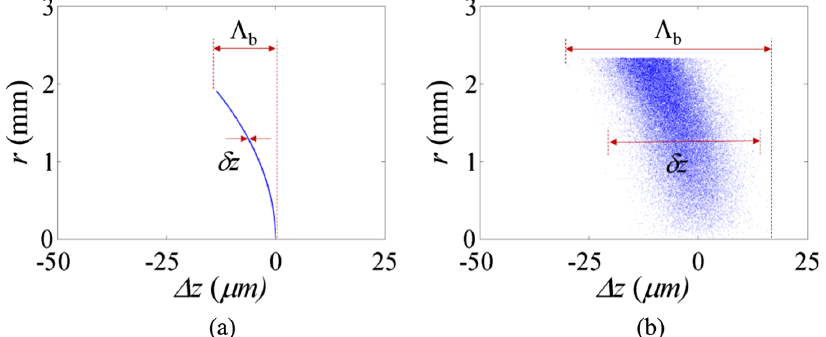
FIG. 2. Half r - Δ z distribution of 100-fC electron beams at the exit of the 1.6-cell, S-band rf photoinjector [42] with E 0 ¼ 100 MV = m. The injection phases are (a) 180° and (b) 200°, respectively. Note that the initial cutoff radius and temporal duration of the beams are 2 mm and 30 fs at the photocathode, respectively. δ z , Λ b , Δ z are the spread of the particle layer, full length of the electron beam, and longitudinal particle position with reference to a particle on the axis,